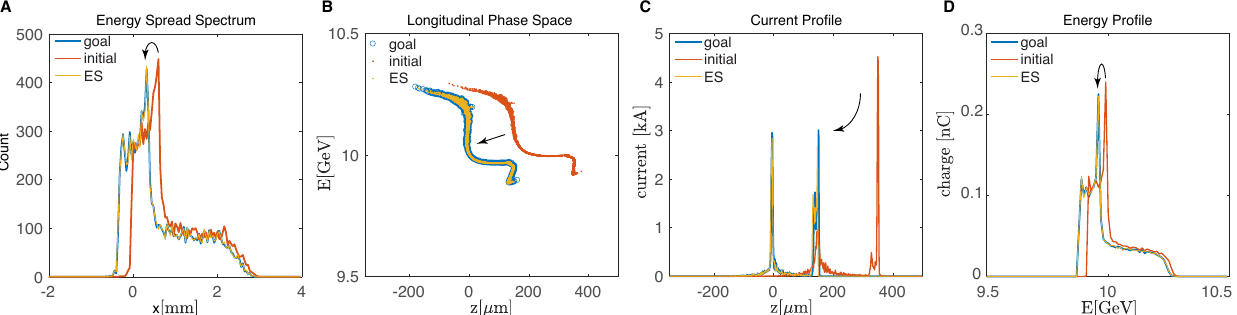
Figure 6. Simulation-based demonstration of adaptive tuning-based phase space diagnostic. Adaptively tuning the model to match a measured energy spread spectrum ( A ). Once the spectrum matches the LPS is uniquely reconstructed ( B ). Projection onto the z-axis gives an accurate diagnostic of the current profile ( C ). Projection onto the E-axis gives an accurate diagnostic of the energy profile ( D